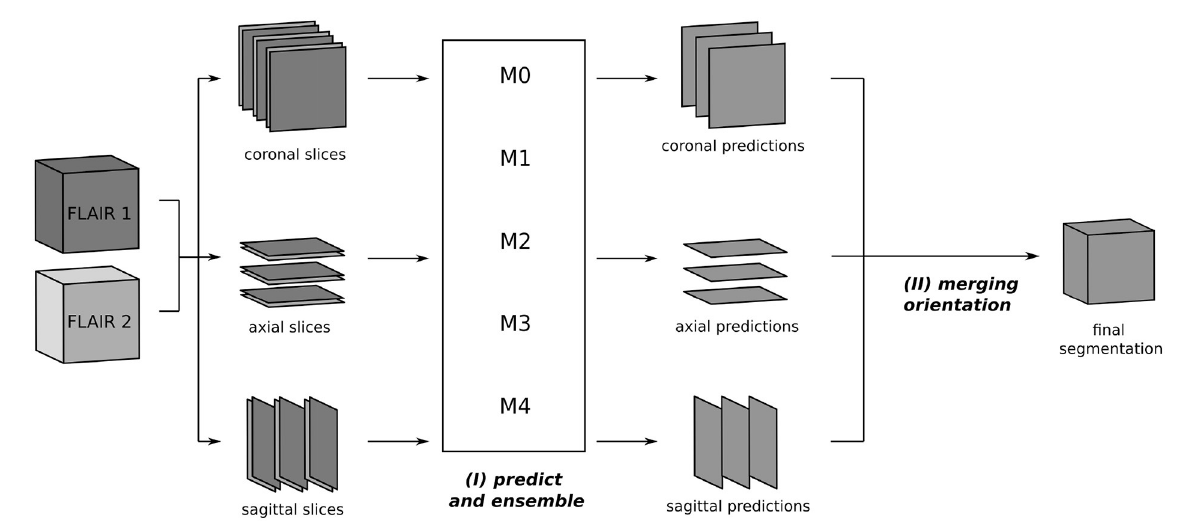
FIGURE2 Segmentation process using the triplanar U-Nets M 0 , ..., M 4 trained on slices from the three orthogonal planes of the different training folds. The 3D FLAIR input volumes are sliced along the coronal, axial, and sagittal planes and grouped together in pairs of corresponding slices. For every orientations, the segmentation is now performed independently: (I) each slice pair is given as a two-channel 2D input to the models M 0 , ..., M 4 and predicted softmax scores are averaged. (II) In the final step, the predictions of the individual orientations are merged to yield the final